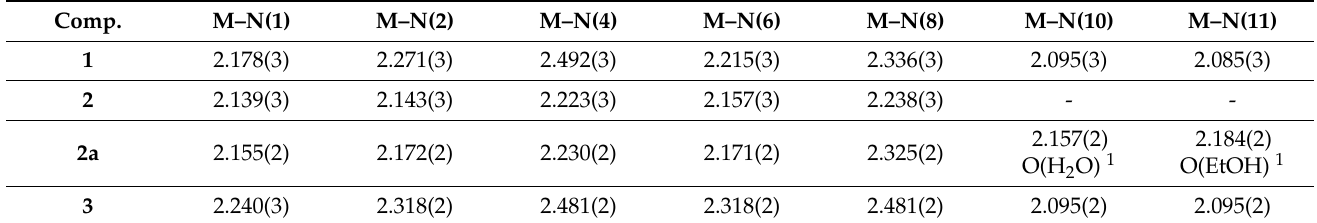
Table 1. Interatomic M-N distances (Å) in compounds 1 – 3 (M = Co ( 1 , 2 ); Fe ( 3 )). Comp.